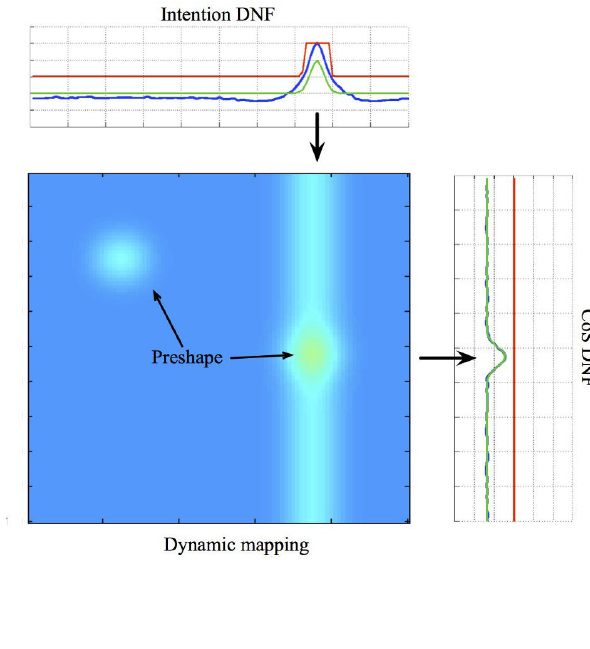
intention and CoS dynamic neural